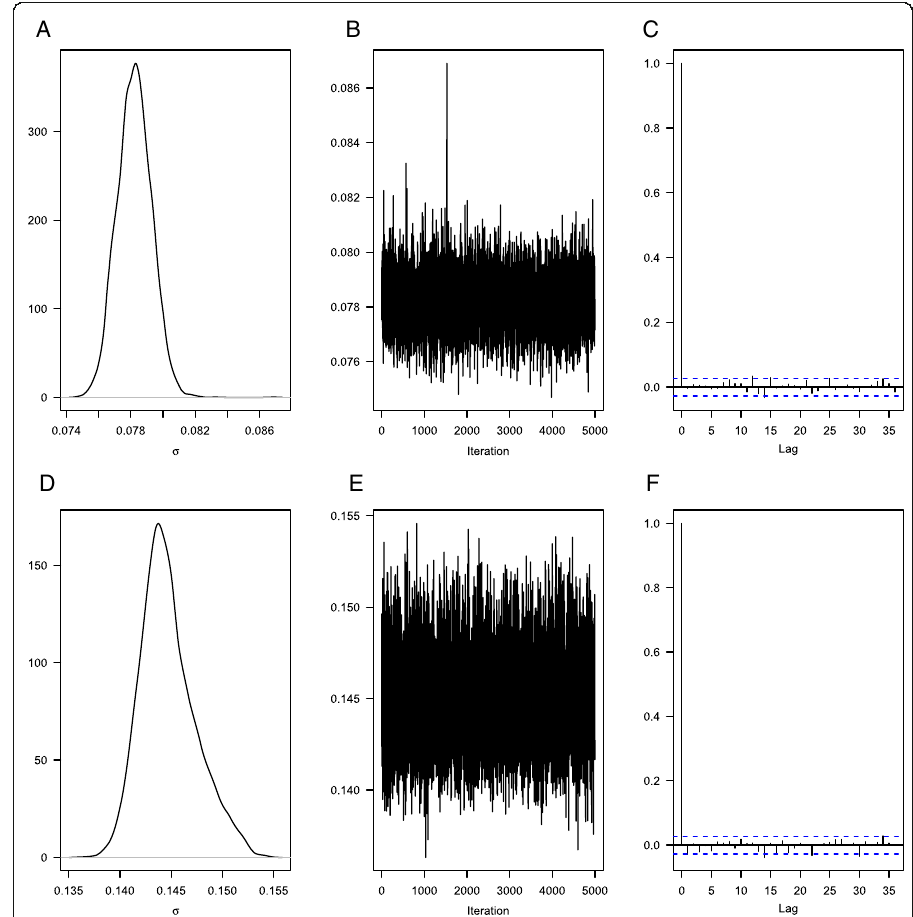
Fig. 7 Marginal posterior density function ( a , d ), traceplot ( b , e ), and autocorrelation function ( c , f ) for the parameter σ in the British ( top : a – c ) and Danish ( bottom : d – f ) validating forecast of our model